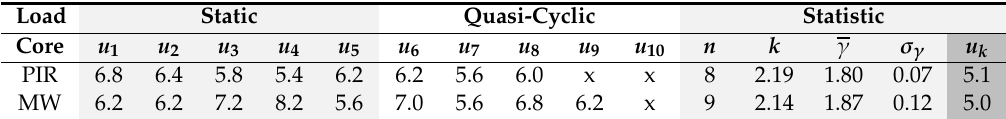
Table 8. Eccentric pull-out—calculation of the characteristic values of the displacements u k (mm). Load